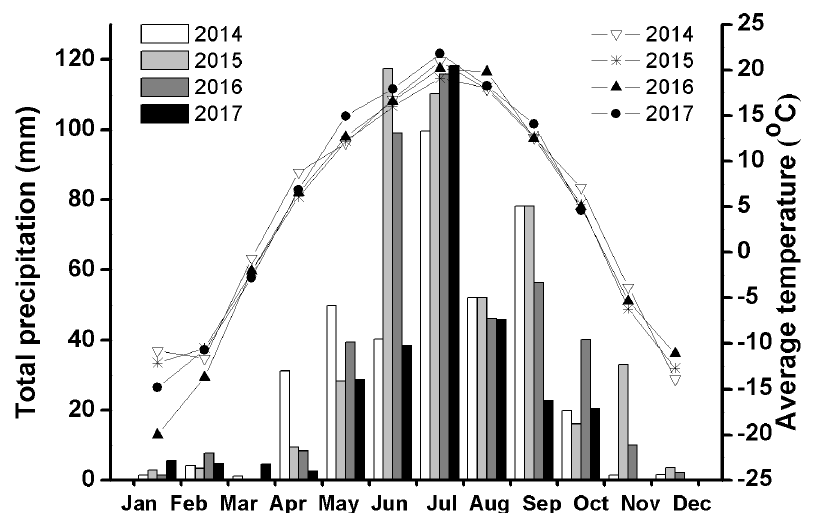
Figure 1. Monthly average temperature (°C) and total precipitation (mm) recorded at Zhenglan Qi Meteorological Station (ID.54205), Inner Mongolia, China, during 2014–2017. Meteorological Station (ID.54205), Inner Mongolia, China, during